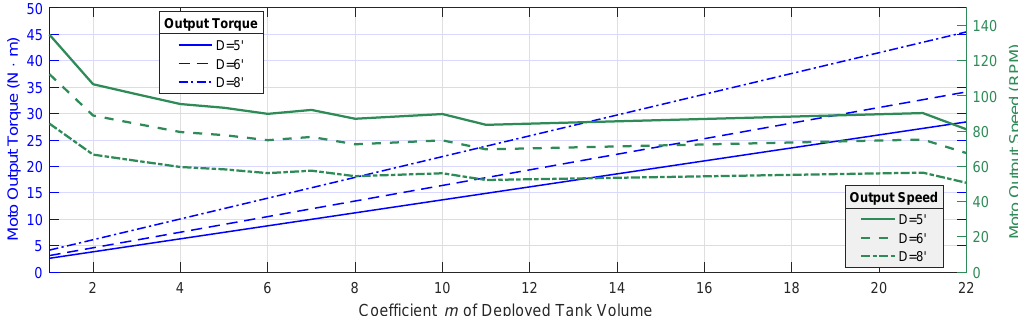
Figure 8. Output torque and speed comparison according to coefficient m and wheel diameter D .